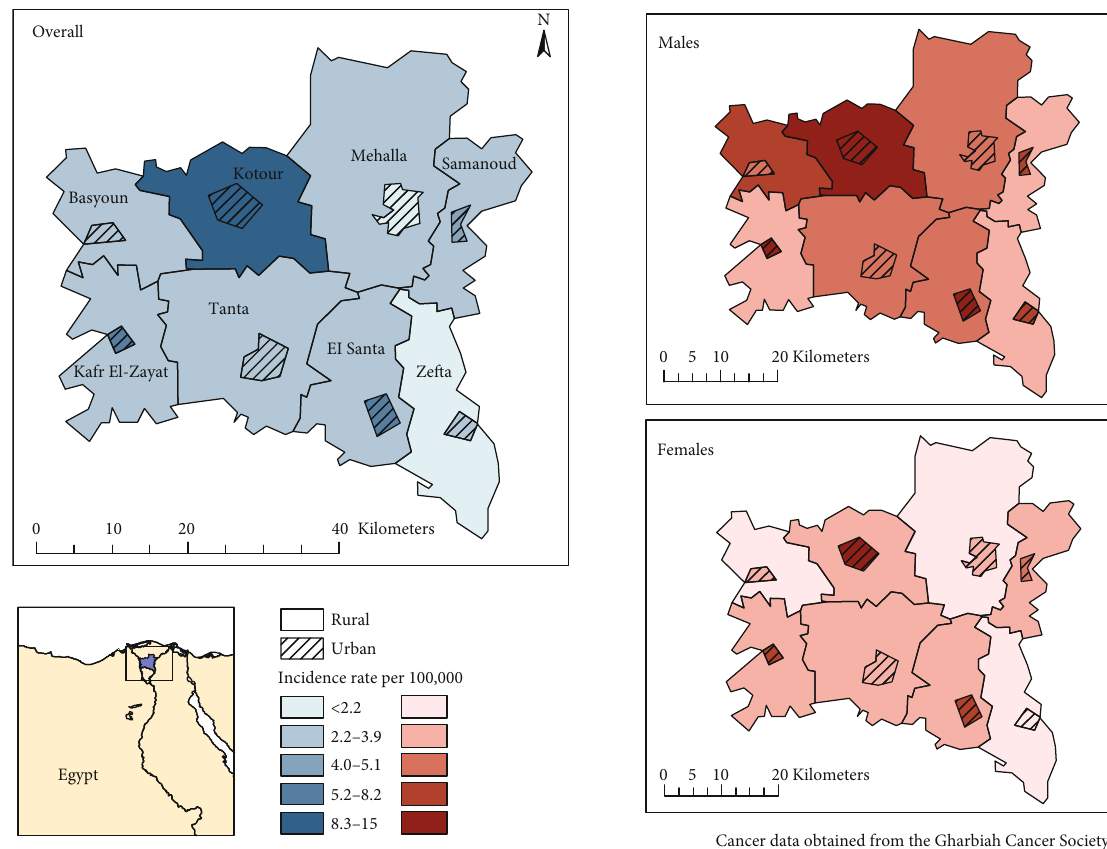
Figure 1: Map of pancreatic cancer incidence rates in urban and rural Gharbiah for males and females